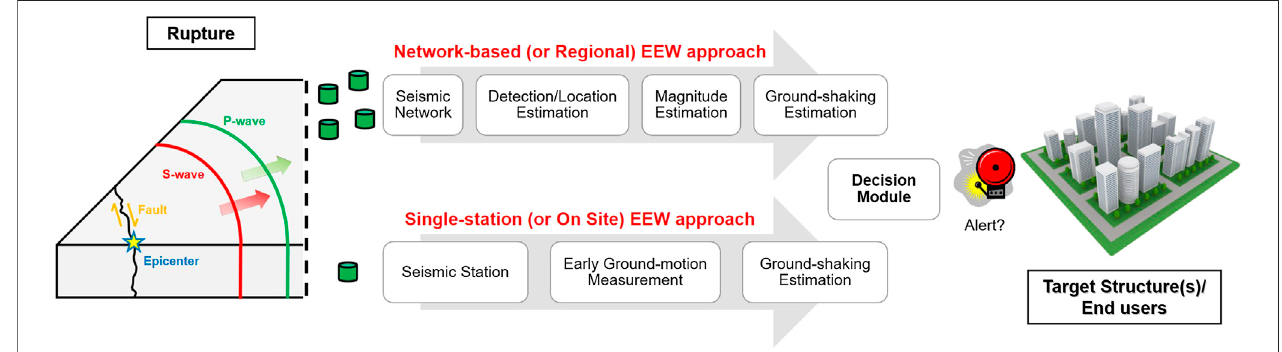
FIGURE 2 | The two possible approaches to earthquake early warning (EEW). In the network-based (or regional) approach, the lead-time is equal to the S-arrival timeatthetargetminusthe fi rst-Patthenetworkminusanyprocessing/computationtime;inthesingle-station(oron-site)approachthelead-timeisequaltotheS-arrival time at the target minus the P-arrival at the